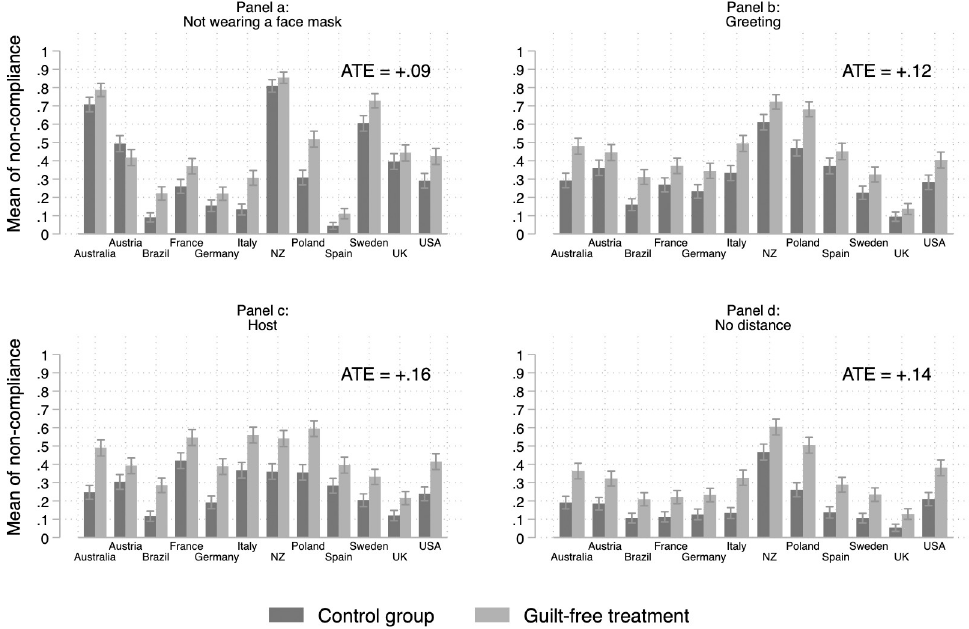
Fig 1. Non-compliance in control and treatment (face-saving) groups. Note: Means of non-compliance are shown with 95% confidence intervals included. ATE = Average treatment effect.